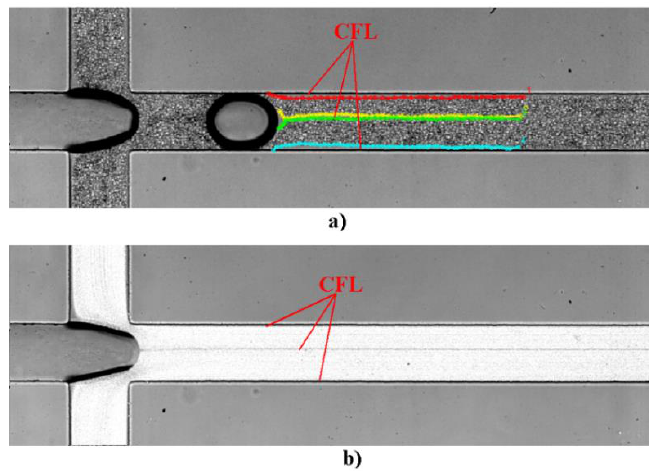
Figure 4. The different cell free layer (CFL) around the walls of the microchannel and in the middle of the channel by the processing image ( a ) MtrackJ and ( b ) Zproject by the ImageJ software.